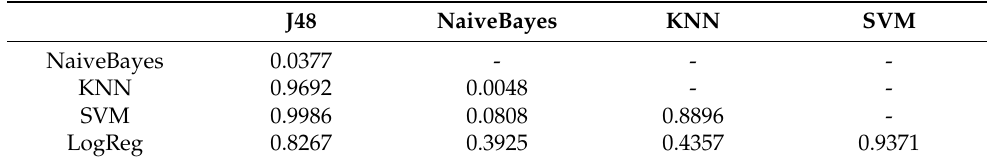
Table 10. Comparison of differences between pairs of classification models by Nemenyi test ( p -values).